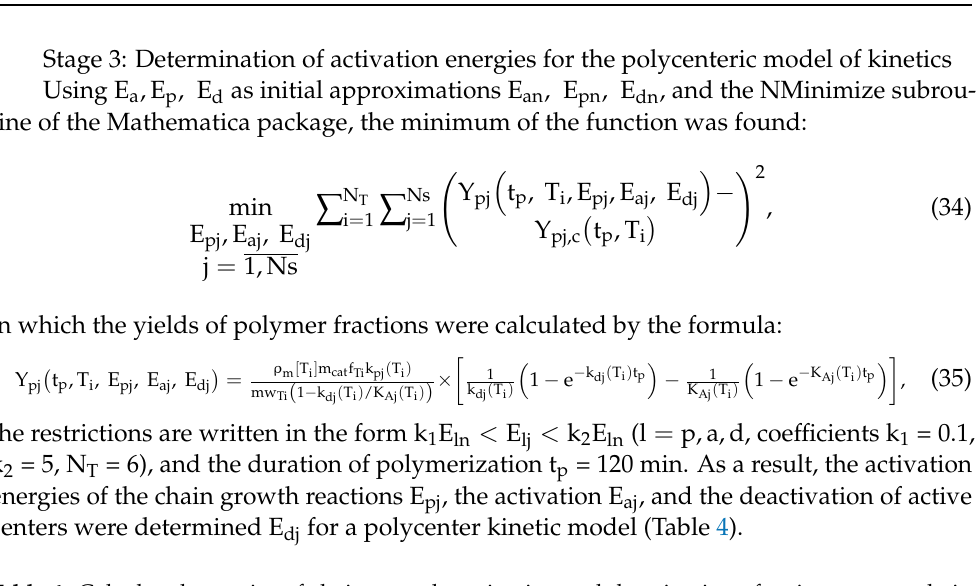
Table 4. Calculated energies of chain growth, activation and deactivation of active centers, chain transfer to monomer and